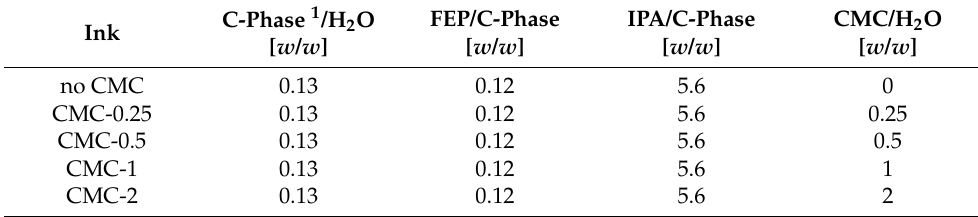
Table 1. Inks composition in terms of relative amounts of the employed components. C-Phase 1 /H 2 Ink